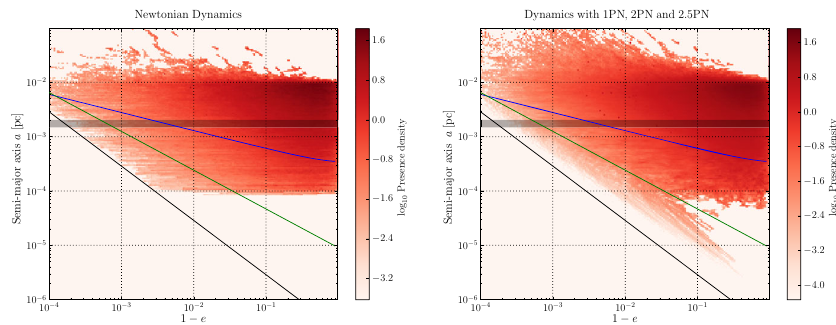
Fig. 56 Integrated presence density for the Newtonian (left panel) and the relativistic case (right panel). ThelinesindicatethepositionoftheSchwarzschild barrierwith C SB = 0 . 35( blue )andthelimitforcapture onto inspiral orbits for non-resonant relaxation ( green